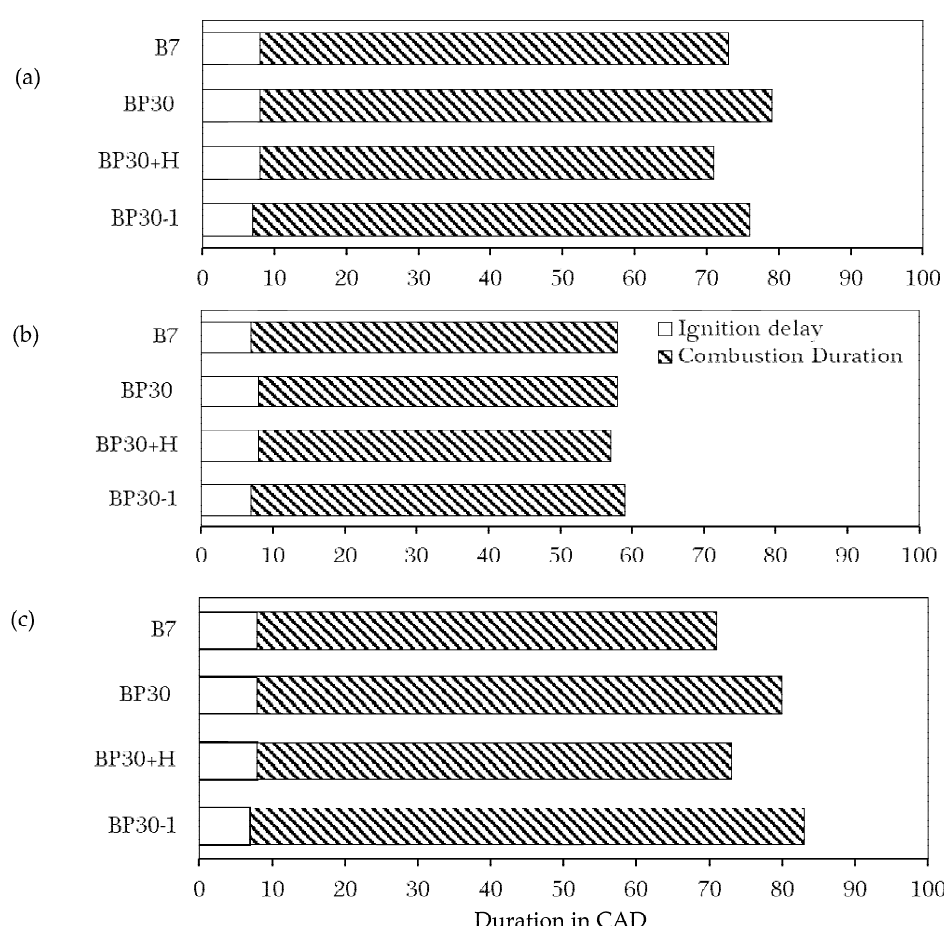
Figure 9. In-cylinder pressure profile and heat release rate in the combustion enhancement process with ( a ) a BMEP of 1.63 bar (25% engine load); ( b ) a BMEP of 2.07 bar (50% engine load); and ( c ) a BMEP of 2.44 bar (75% engine load).